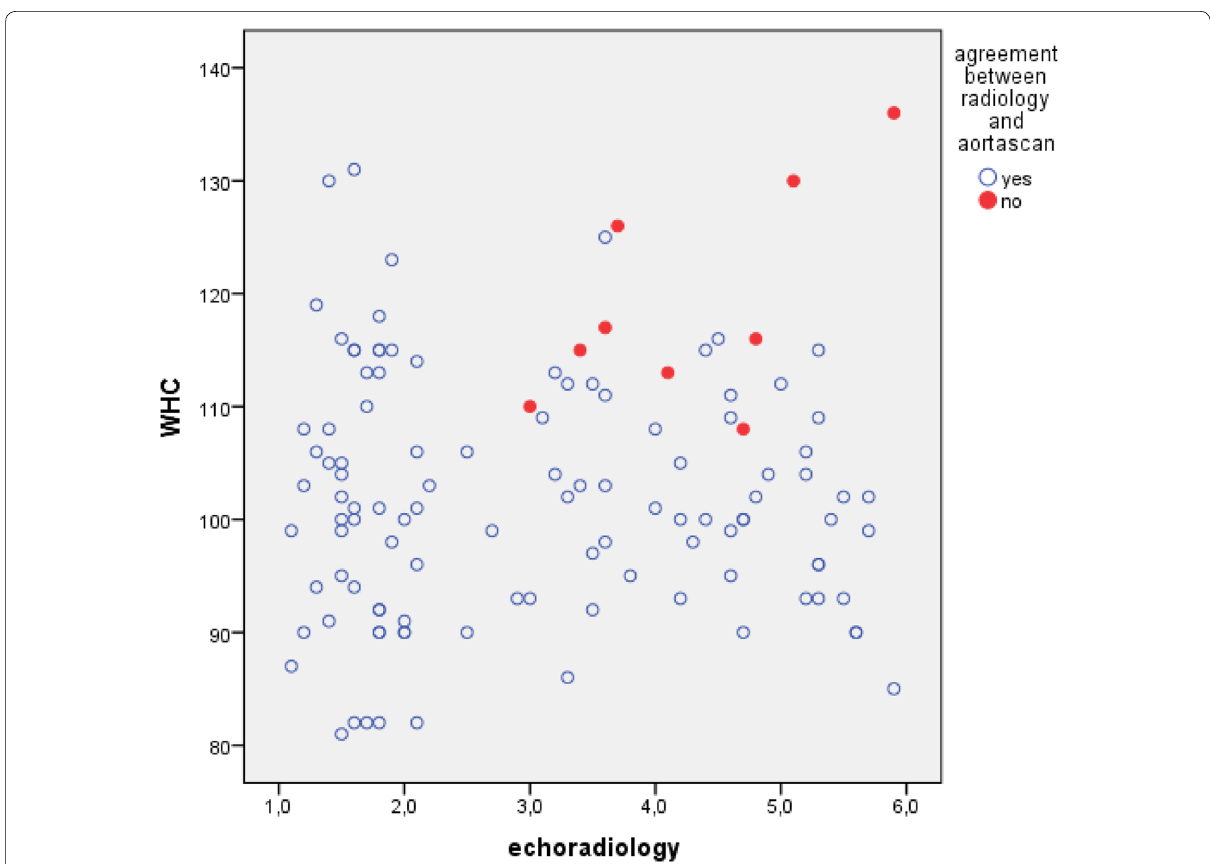
Fig. 1 Plot between the WHC and measurement of AAA. Patients for whom disagreement was observed between Aorta Scan and conventional radiology are shown in red ( n 9) =